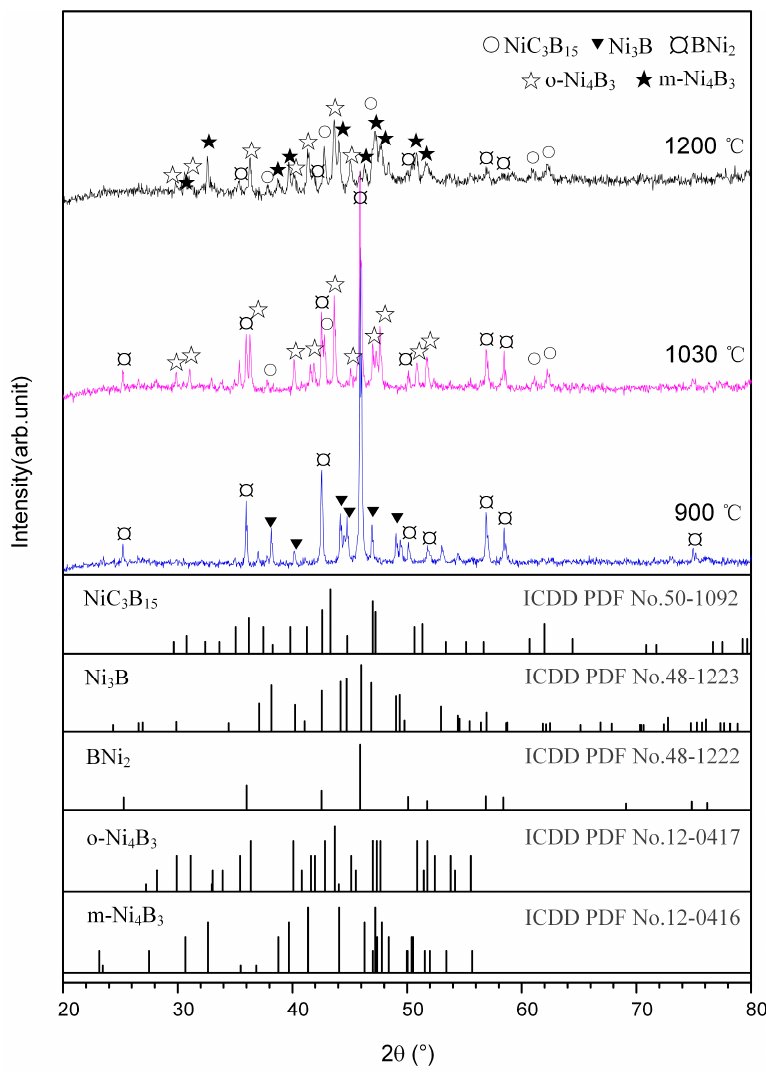
Figure 3. XRD patterns for the DSC products of Ni-B 4 C mixtures quenched at different tempera- tures.